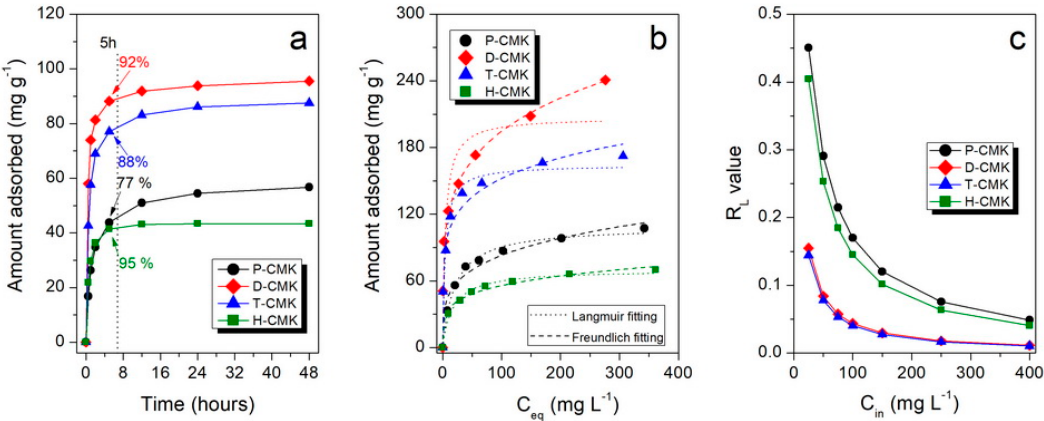
Figure 5. ( a ) DICL adsorption kinetics onto the studied CMK materials (initial concentration of DICL: 50 mg L − 1 ), ( b ) adsorption isotherms along with their fitting using Langmuir and Freundlich models, ( c ) values of separation factor (R L ) for different DICL initial concentrations used in this study. Table 3. Sorption capacities (SC) of DICL and parameters calculated from the Langmuir and Freundlich fitting .